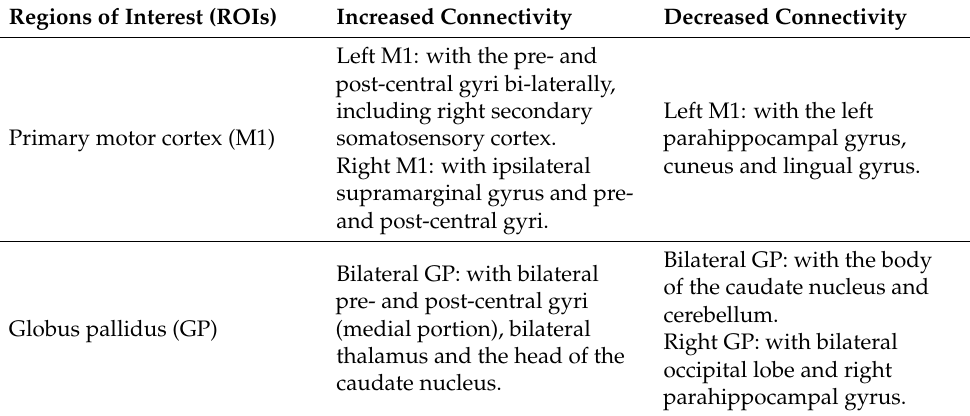
Table 1. Increased and reduced functional connectivity of the patient’s regions of interest (ROIs), compared to the control group.